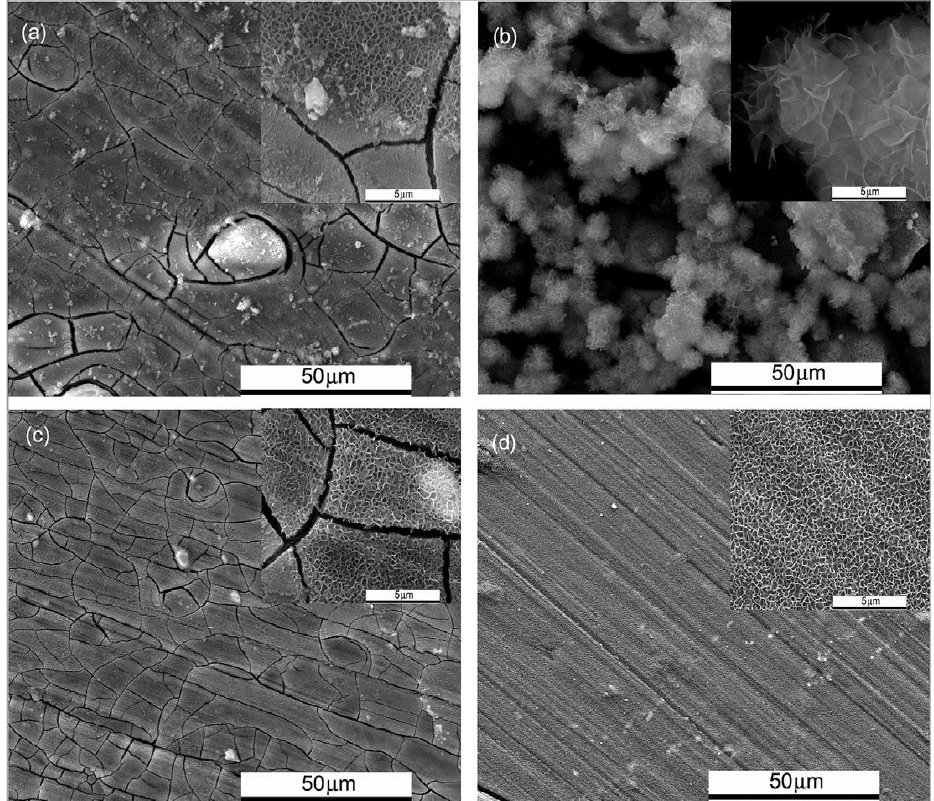
Figure 15. SEM micrograph of the surface of GW103 alloy after 24 h of immersion in ( a ) blank solu- tion; ( b ) blank solution + 0.1 mM zinc nitrate; ( c ) blank solution + 0.5 mM APTS – Na and ( d ) blank solution + 0.5 mM APTS – Na + 0.1 mM zinc nitrate [176] . “Blank solution” is a corrosion testing solution from ASTM D1384, which consists of corrosion test solution: 184 mg/L Na 2 SO 4 + 138 mg/L